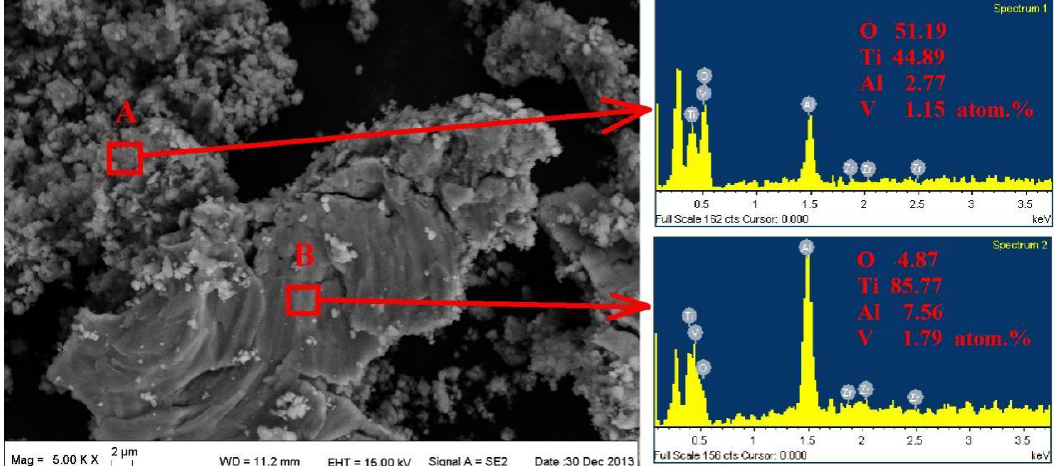
Figure 16. Pattern and energy-dispersive X-ray spectroscopy analysis of wear debris of Ti6Al4V alloy.